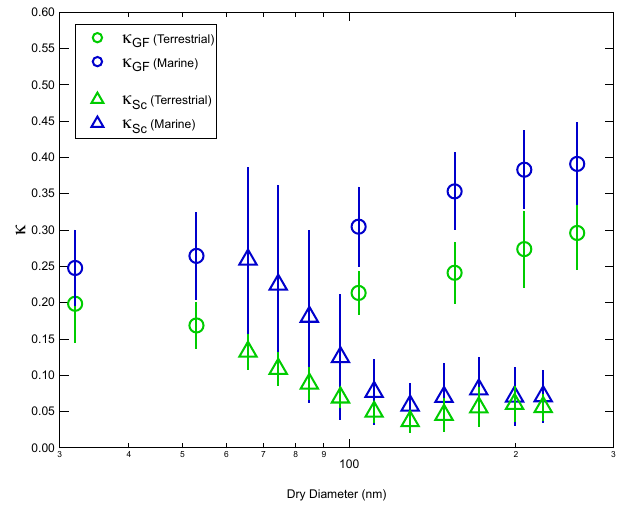
Fig. 9. κ vs. dry diameter, for the CCNc (triangles) and HTDMA (circles) measurements, both for Terrestrial (green) and Marine (blue)